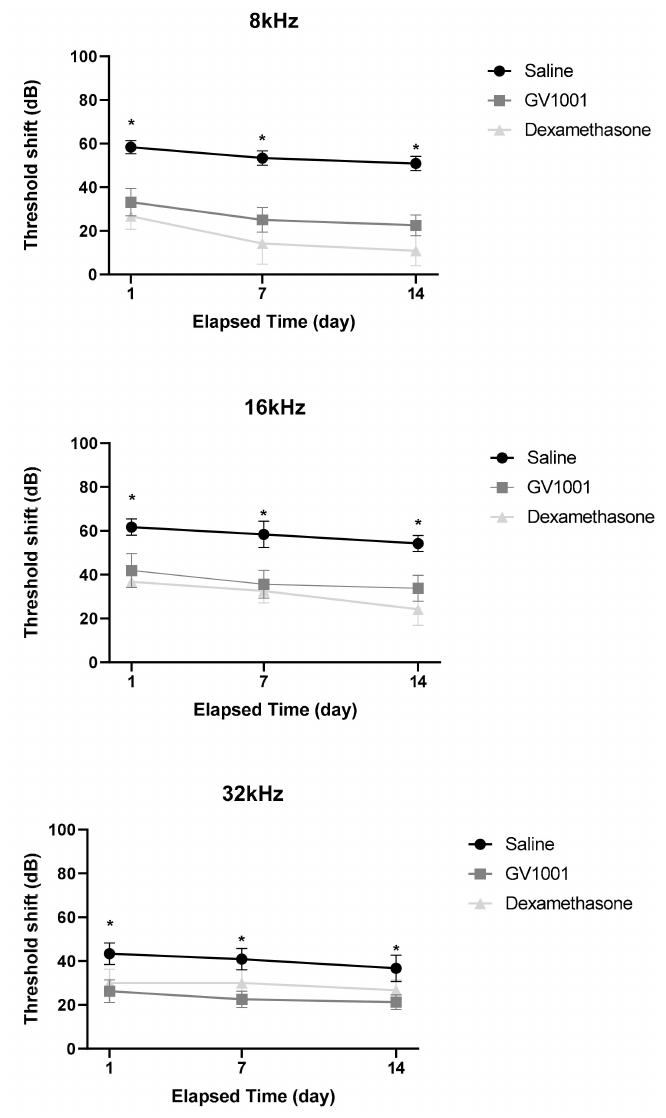
Figure 2. E ff ect of GV1001, dexamethasone and saline treatment in noise-induced hearing loss (NIHL) murine model induced by severe PTS-noise. Threshold shift (dB) relative to baseline at post-treatment 1 day, 7 days, and 14 days among the GV1001, dexamethasone and saline groups is illustrated according to frequencies. All groups contained 17 mice. The Error bars in threshold shift panels are SEM. * p < 0.05 (by one-way ANOVA with the Tukey post-hoc